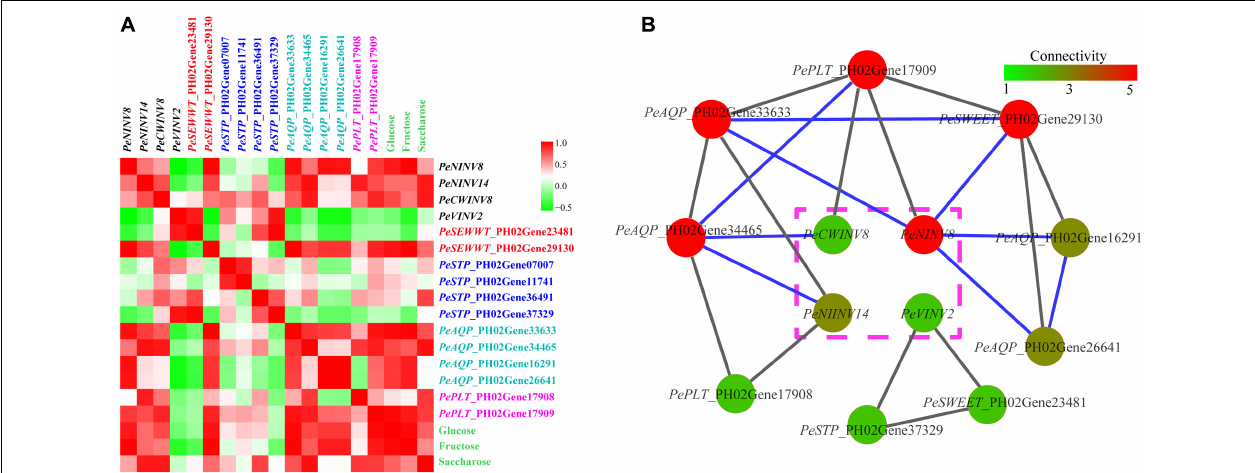
FIGURE 8 | Correlation and co-expression analyses. (A) The correlation analysis of sugar contents with the expression levels of 4 PeINV s and 12 SWTG s. Each correlation is shown by the shades of green to red square shape. The gradual change color of green to red indicate negative to positive correlation. (B) Co-expression network of four PeINV s with nine SWTG s. Gray lines represent PCC magnitude from 0.8 to 0.9, and blue lines represent PCC magnitude from 0.9 to 1.0. The gradual change in the color of nodes represents the difference in the enriched number of co-expressed